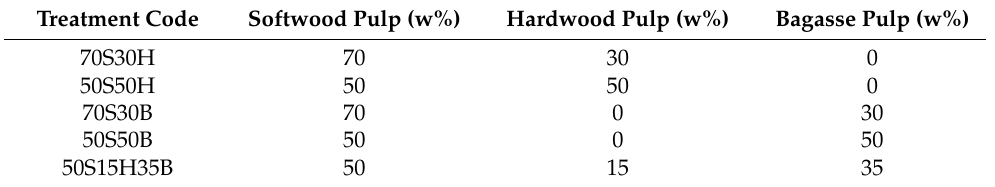
Table 1. Percentages of softwood pulp, hardwood pulp and bagasse pulp in different treatments. Treatment